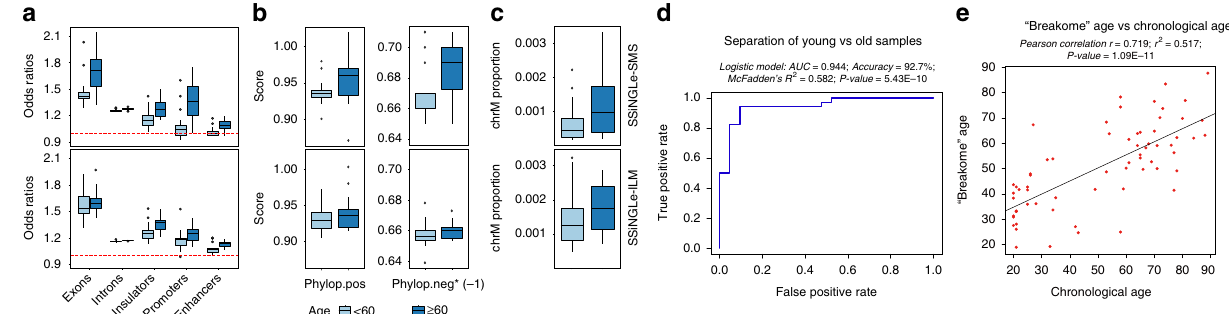
Fig. 5 Association of various genomic features of SSBs with age. PBMC samples were strati fi ed into <60 and ≥ 60 years old groups (respectively 18 and 22 for SSiNGLe-SMS and 23 and 21 for SSiNGLe-ILM). a Box plot distributions of the odds ratios of enrichment of SSBs in exons, introns, promoters, insulators and enhancers. b Box plot distributions of average PhyloP positive or negative scores (absolute values are shown) in ±20 bp windows. c Box plot distributions of the breaks mapping to chrM. Upper panels represent SSiNGLe-SMS while lower panels SSiNGLe-ILM. d The ROC curve and properties of the logistic model built to classify 21 “ young ” ( ≤ 30 years-old) and 34 “ old ” ( ≥ 58 years-old) individuals. e The scatter plot of “ breakome ” age ( Y -axis) vs chronological age ( X -axis). The “ breakome ” age was predicted using multiple linear model for the 66 samples of all ages. Samples in (d) and (e)